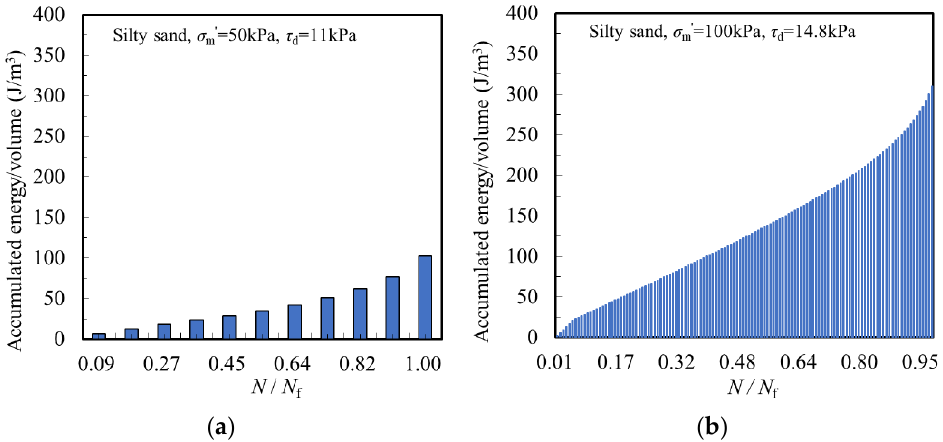
Figure 11. Comparison of energy dissipations for silty sand under different σ m ’ and τ d : ( a ) Silty sand, σ m ’ = 50kPa; ( b ) Silty sand, σ m ’ = 100kPa.